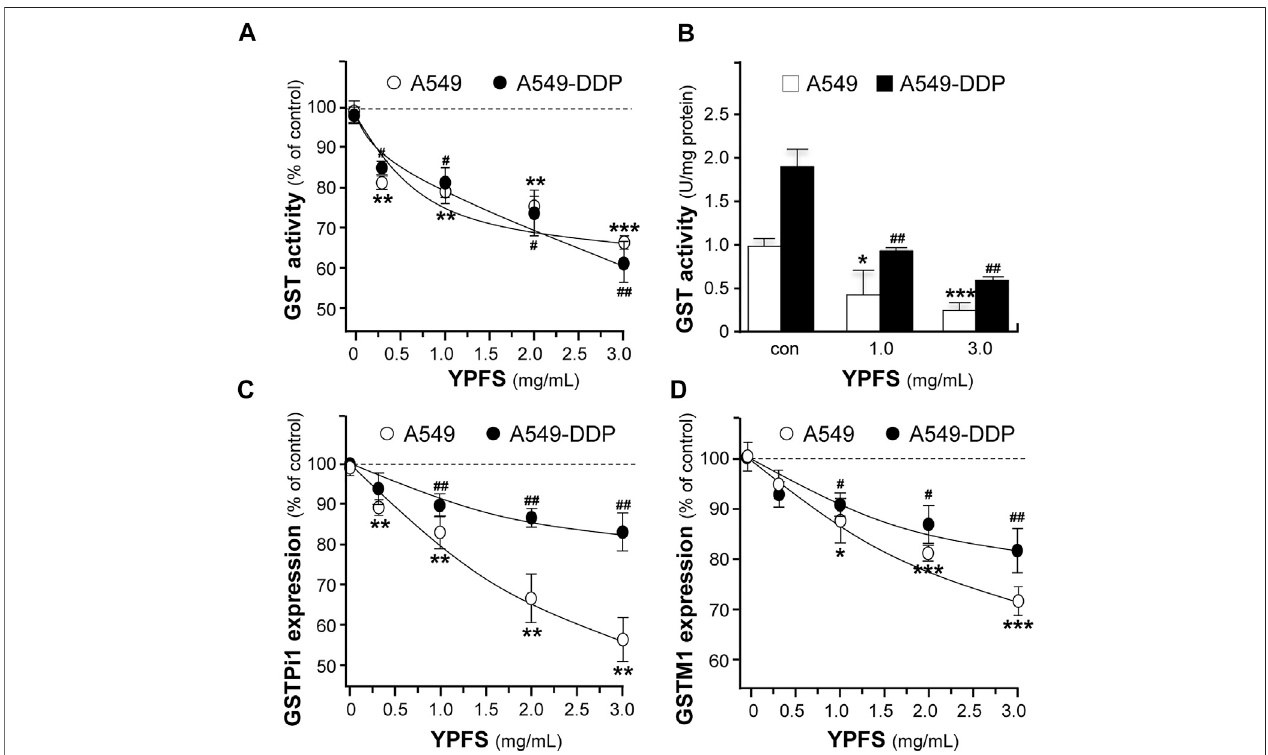
FIGURE 3 | YPFS suppresses GST activity and expression in cultured A549 and A549-DDP cells. (A) : Cultured A549 and A549-DDP cells (40,000/well in 12-well plate) were treated with YPFS for 48 h, and then the activity of GST was determined. (B) : YPFS was applied to A549/A549-DDP cell lysate, and then GST activity was measured. Values are expressed as unit of GST activity. (C and D) : Cultured A549 and A549-DDP cells (120,000/well in 6-well plate) were treated with YPFS for 24 h, and then mRNA expression levels of GSTPi1 (C) and GSTM1 (D) were determined using quantitative real-time PCR. GAPDH was used as an internal control for normalization. Values are expressed as % of control (no drug), in mean ± SEM, n (cid:2) 3. * or # , p < 0.05, ** or ## , p < 0.01, *** or ### , p <